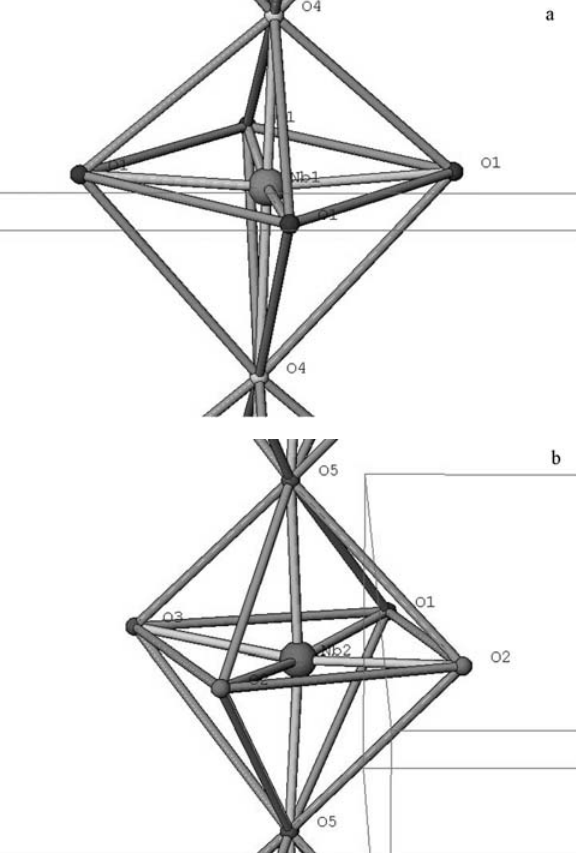
Figure 5. (a) The displacement occurs parallel to the c direction only for the Nb1 atoms; (b) in the Nb2 also there are components in a and b directions (small inclination of 3.8° observed in the disposition of the Nb2-O5 bonds).